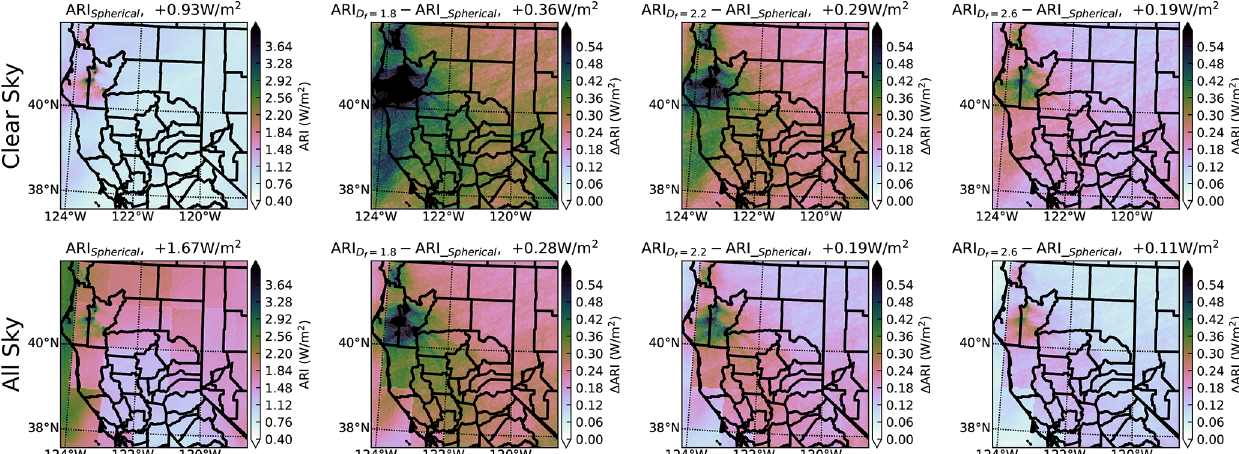
Figure 15. Similar to Fig. 14, but for the northwest